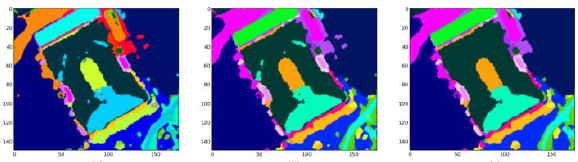
Figure 4: (a) Segmentation result. (b) Segmentation after merging small areas. (c) Segmentation after merging based on